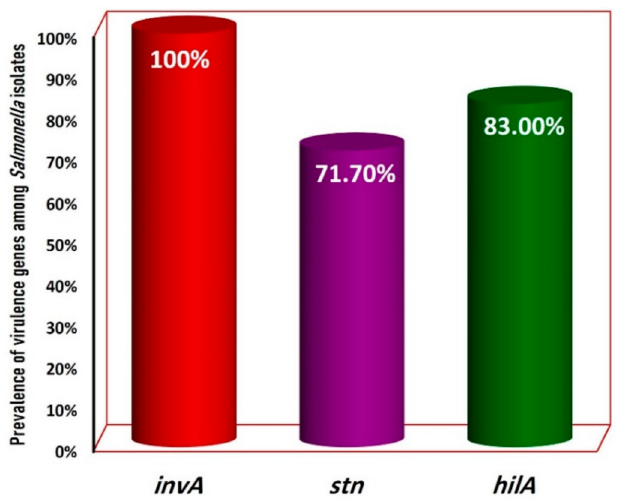
Figure 3. Prevalence of virulence genes among the screened Salmonella isolates (n =